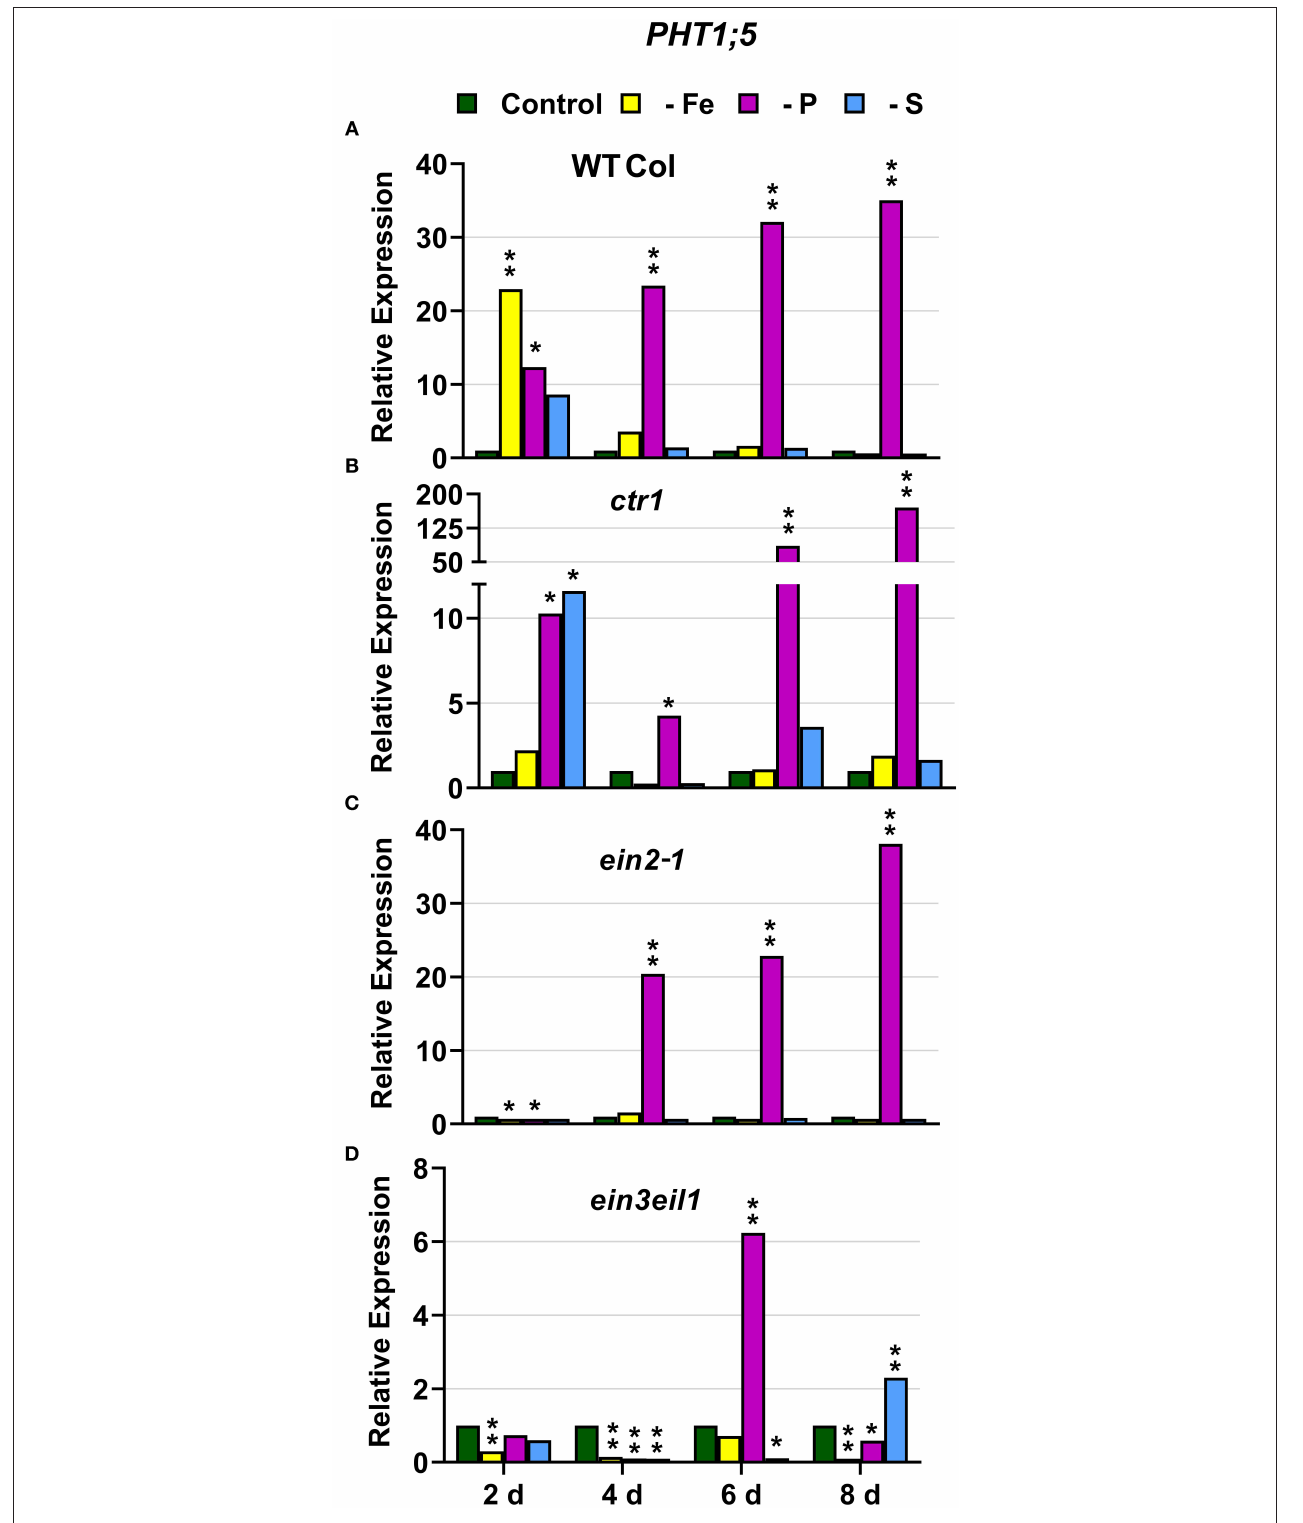
FIGURE 4 | Effect of Fe, P or S deficiency on the expression of the P-related gene PHT1;5 in roots of the Arabidopsis WT Columbia and its ethylene mutants ctr1 , ein2-1 and ein3eil1 (A–D) . Treatments and gene expression determination as in Figure 1 . Within each day and genotype, * or ** indicate significant differences ( P < 0.05 or P < 0.01) in relation to the control